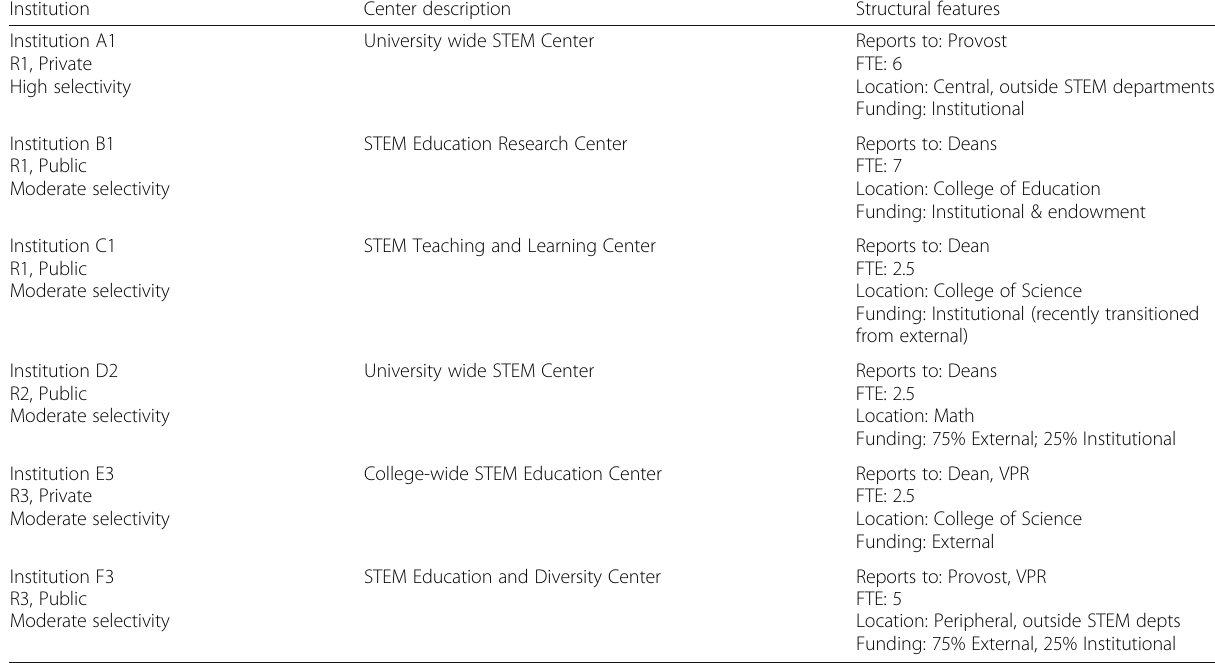
Table 1 Institutions and SECs: structural